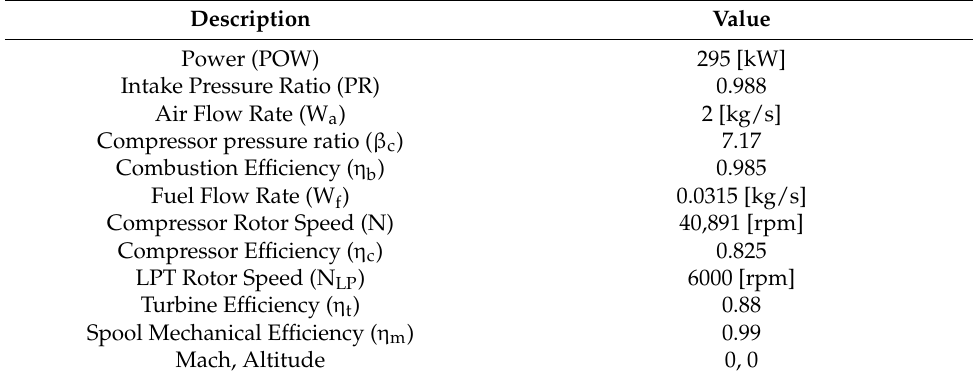
Table 2. PW200 design